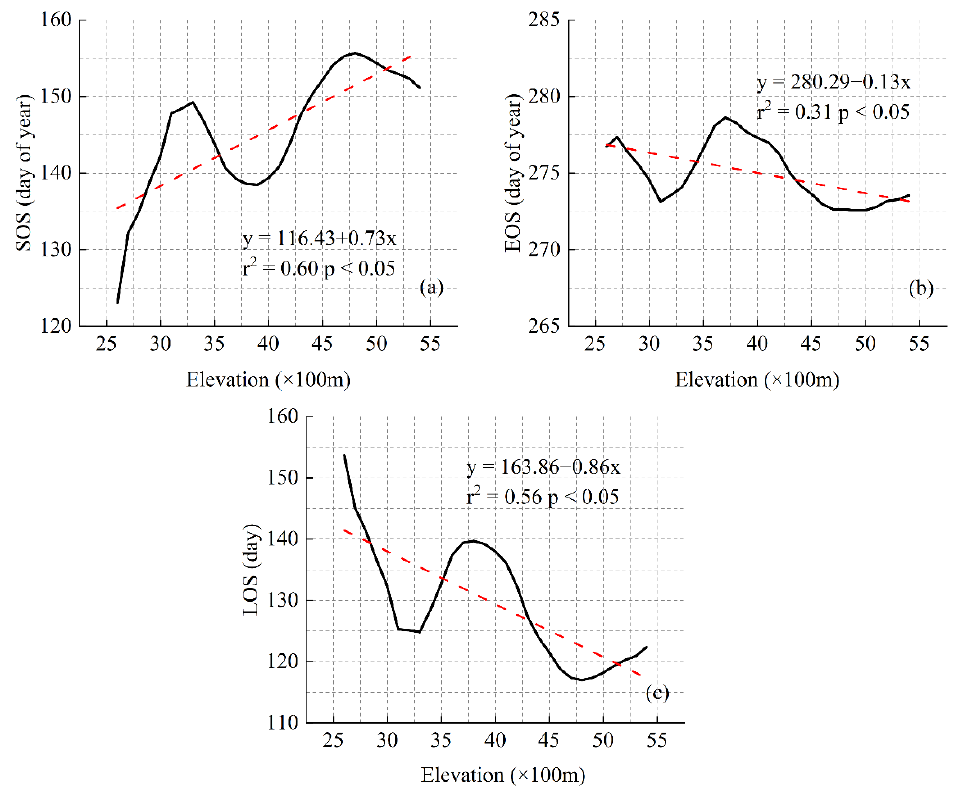
Figure 6. Relationship between altitude and vegetation phenology in the Three-River headwaters region. ( a ) Relationship between altitude and the SOS. ( b ) Relationship between altitude and the EOS. ( c ) Relationship between altitude and the LOS.